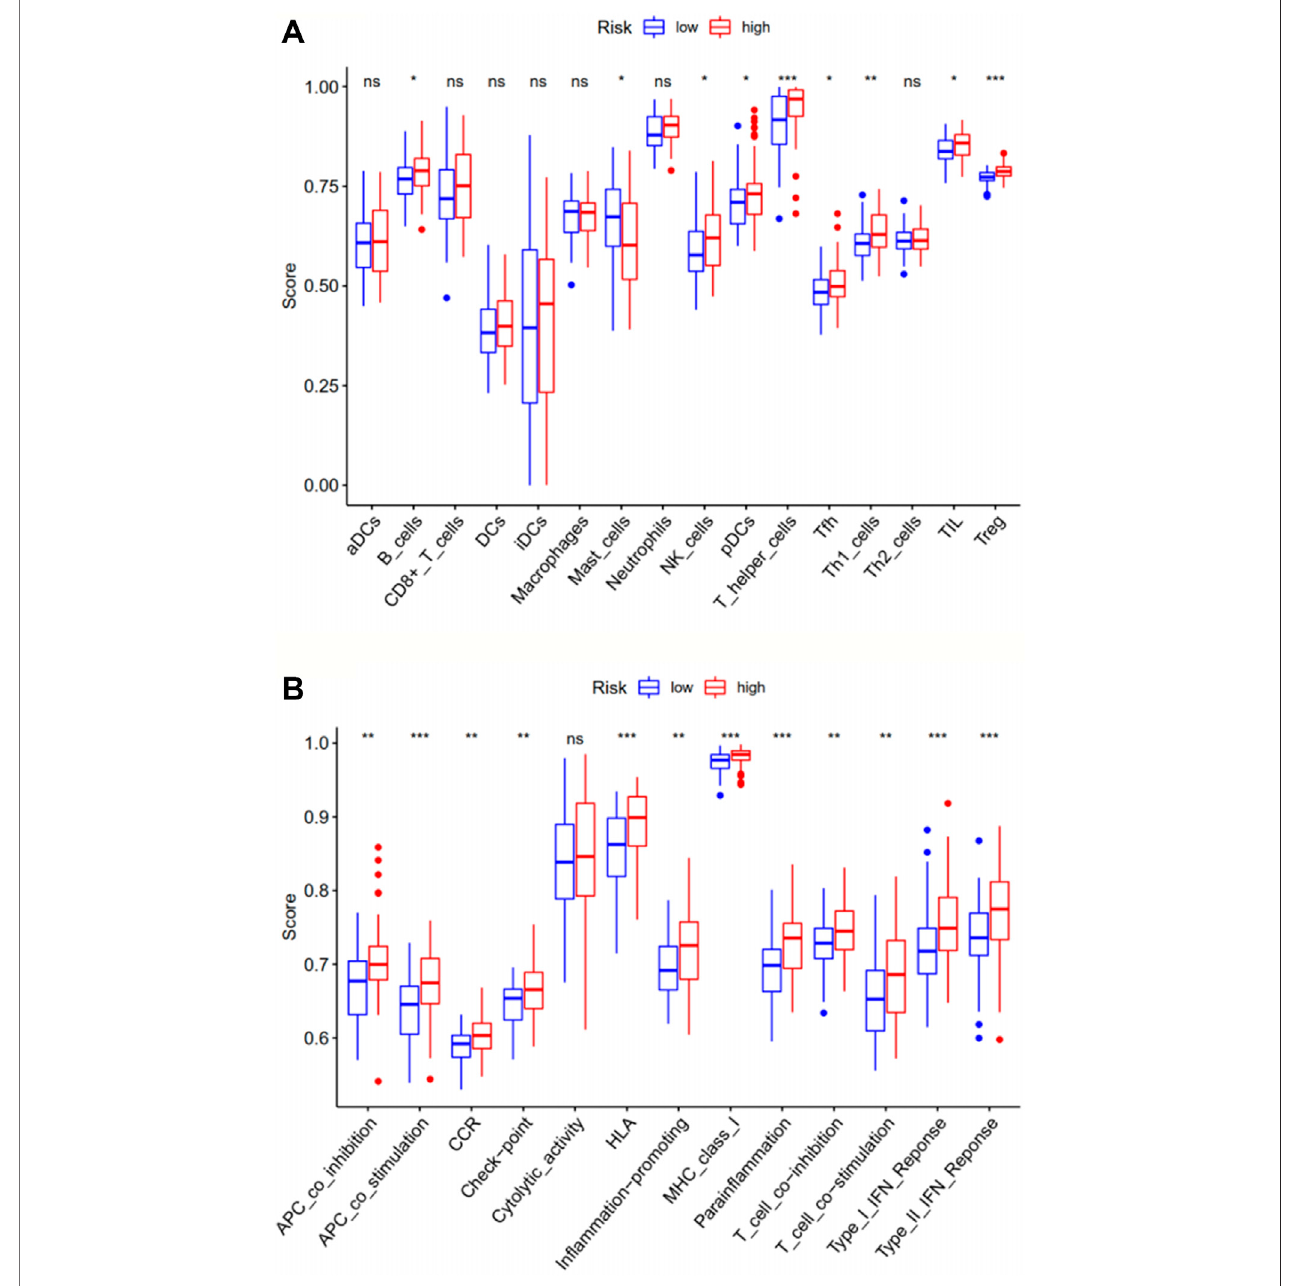
FIGURE5| ThessGSEAanalysiscomparesimmunecells( A )andimmune-relatedfunctions( B )betweenthetworiskgroupsinthetrainingsetTCGA-LAML.***, p < 0.001; **, p < 0.01; *, p < 0.05; ns, p > 0.05. ssGSEA: single-sample gene set enrichment analysis.